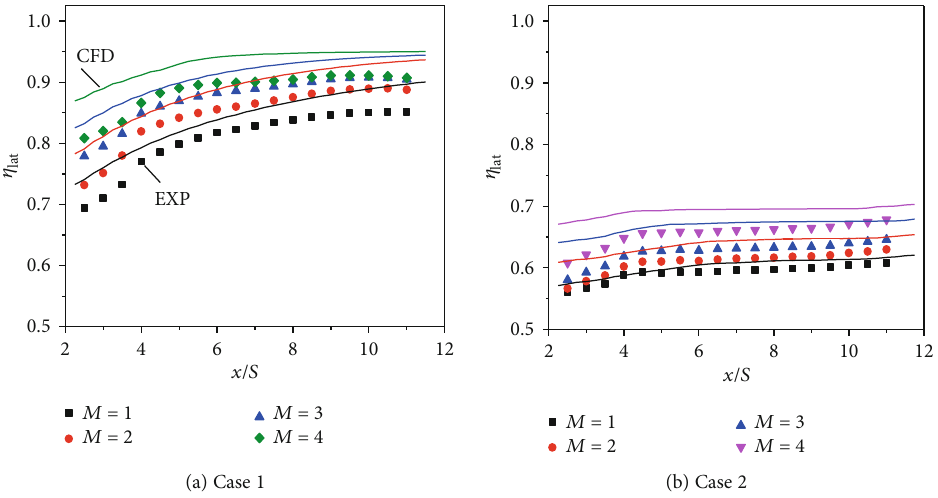
Figure 8: Comparison of the spanwise averaged overall cooling e ff